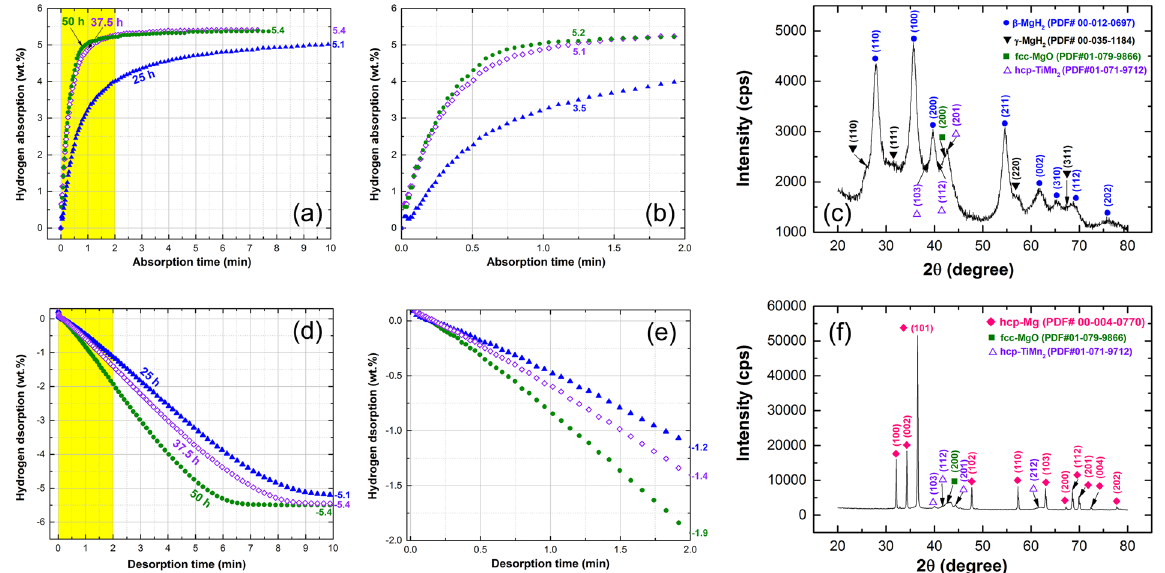
Figure 6. Effect of RBM time on the hydrogenation/dehydrogenation Kinetics measured at 275 °C for nanocomposite MgH 2 /5 wt.% TiMn 2 powders. The full-time-scale (10 min) of hydrogenation and dehydrogenation kinetics examined at 275 °C are displayed in ( a , d ), respectively. The first-2 min corresponding to the yellow shaded zones shown in ( a , d ) are displayed in ( b , e ), respectively. XRD patterns of the nanocomposite samples obtained after 50 h and then subjected to hydrogenation, and dehydrogenation processes at 275 °C are presented in ( c , f ),